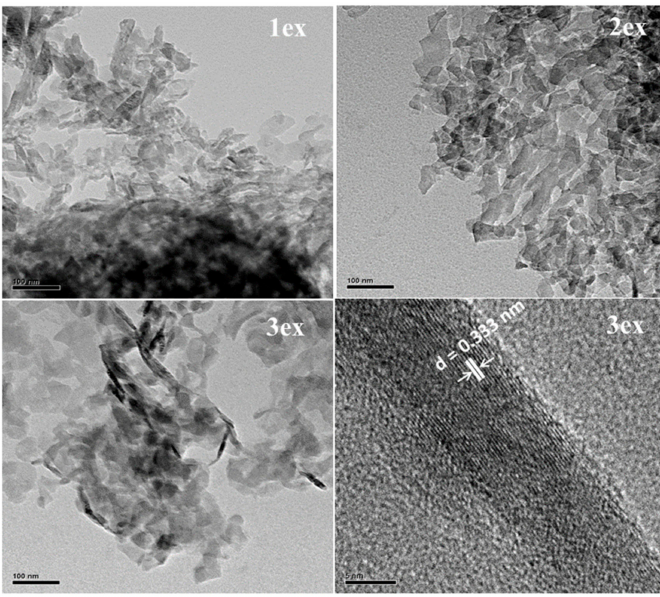
Figure 3. TEM images of the exfoliated (1ex, 2ex and 3ex) g-C 3 N 4